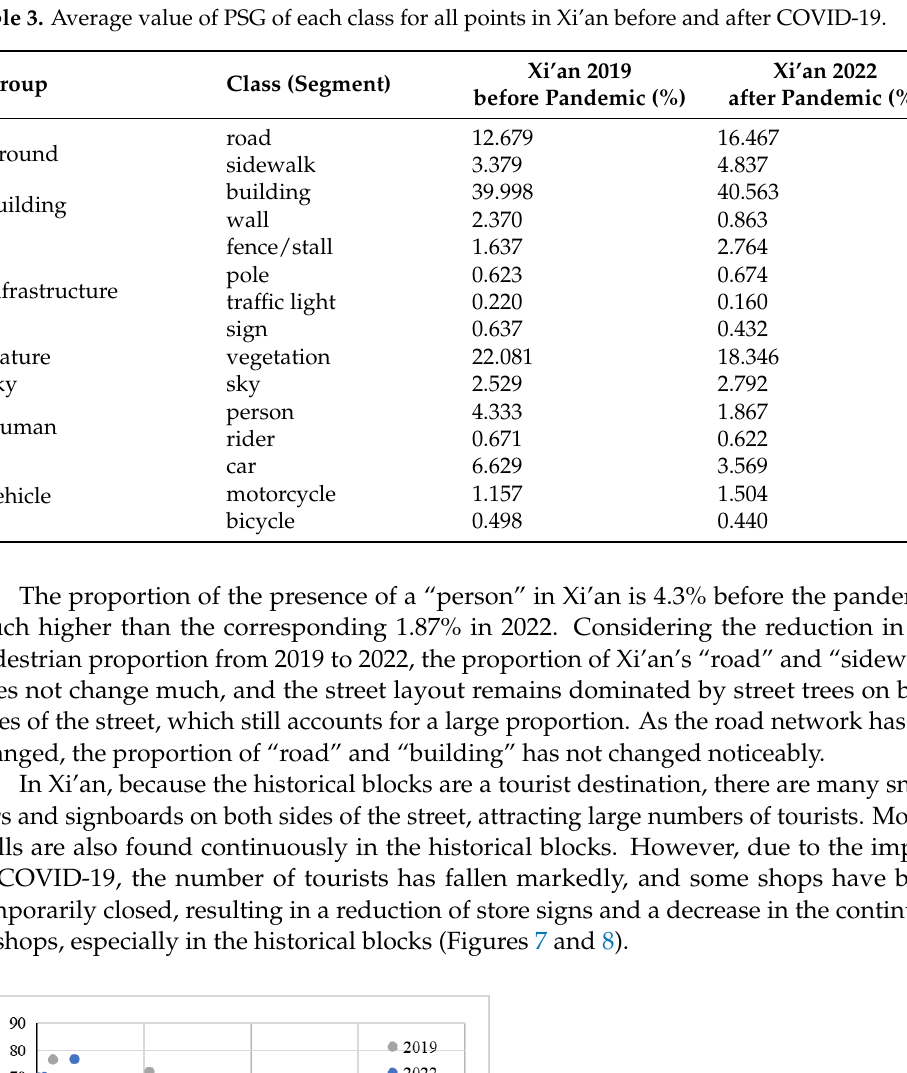
Figure 8. PSG of building-to-sign ratio in the historical areas.